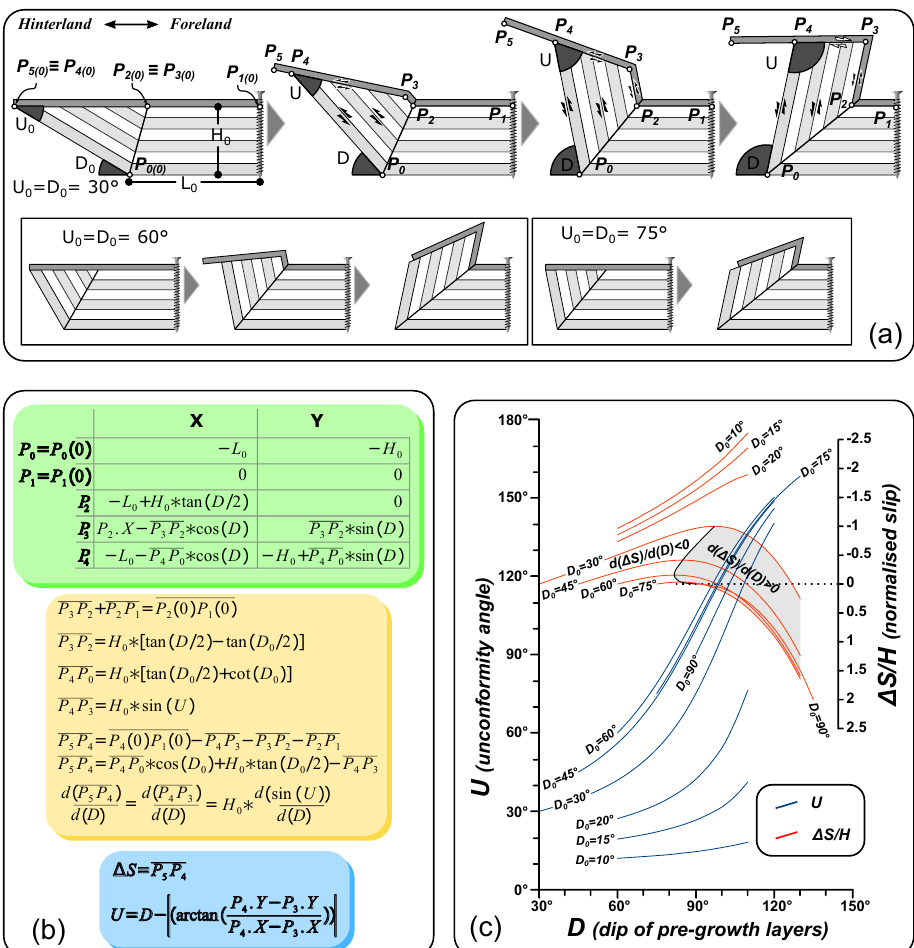
Figure 6. (a) Evolving angular relationships between unconformable sequences during flexural folding in the inner limb of a syncline, with incremental slip senses along pre-unconformity layers and along the unconformity indicated for different initial unconformity angles. The position of six points undergoing folding is illustrated, as well as the dip of pre-unconformity layers ( D) and of the unconformity angle ( U) , which is the angle between the unconformity and the underlying layers. (b) X and Y coordinates of the six points of (a) , with length of segments, and derived amount of slip along the unconformity ( (cid:49) S) and unconformity angle ( U ). (c) Graphical solution of equations in (b) . Blue lines relate the unconformity angle ( U) to the dip of pre-growth strata ( D) for different initial unconformity angles ( U 0 ) . Red lines relates the normalised slip along the unconformity in the inner portion (i.e. (cid:49) S = P 4 P 5 segment divided H) to D for different initial unconformity angles ( U 0 ) . Notice that the y axis for red lines is on the right and that positive and negative values are flipped. The lines indicate the cumulative slip along the unconformity, while the grey area bordered by the black line indicates the area where the incremental slip is